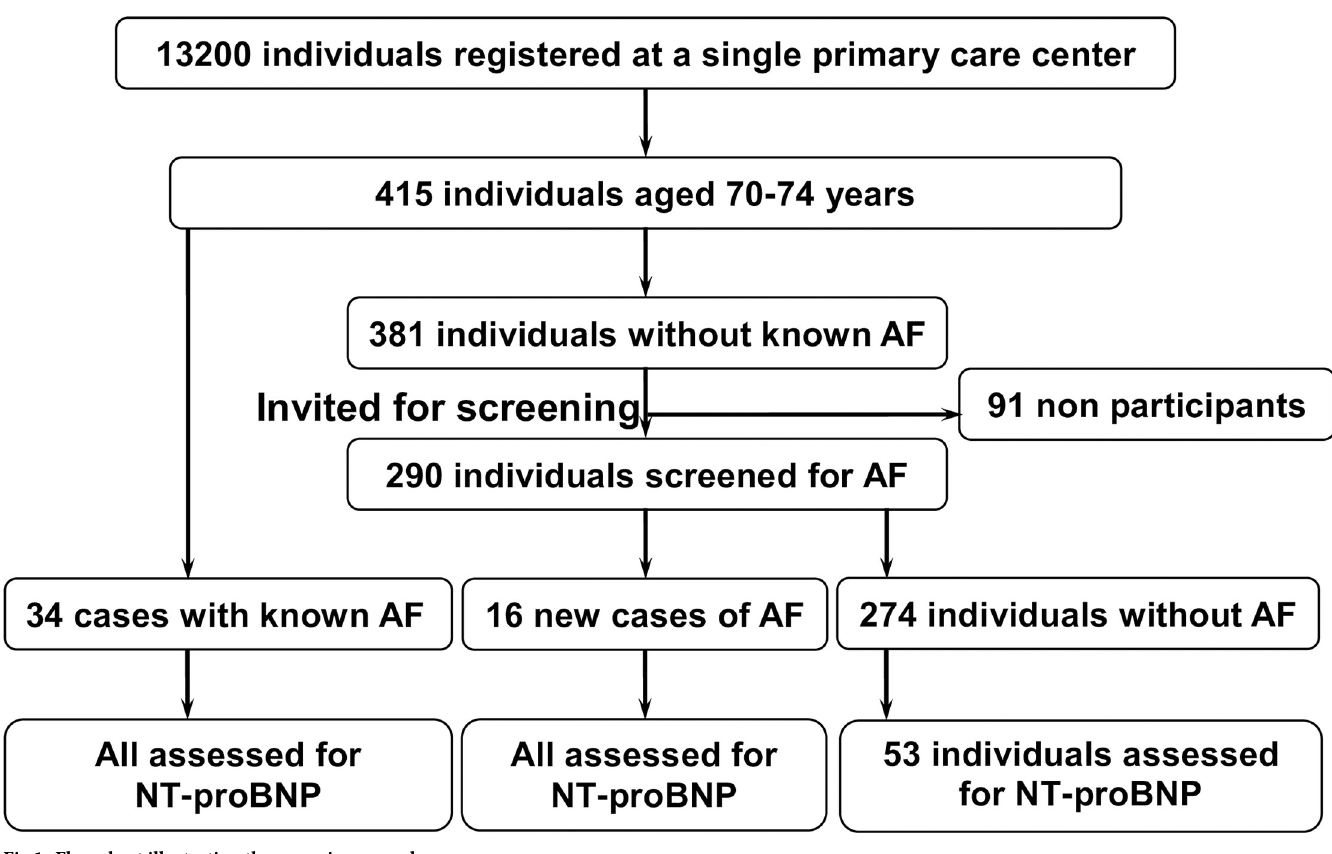
Fig 1. Flow chart illustrating the screening